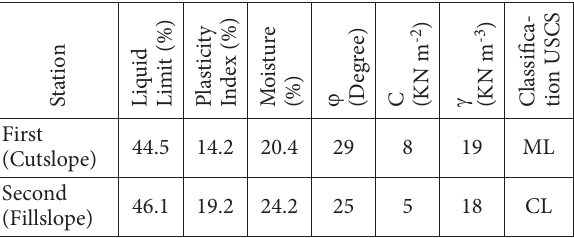
Table 1. Mechanical characteristics of soil in study area